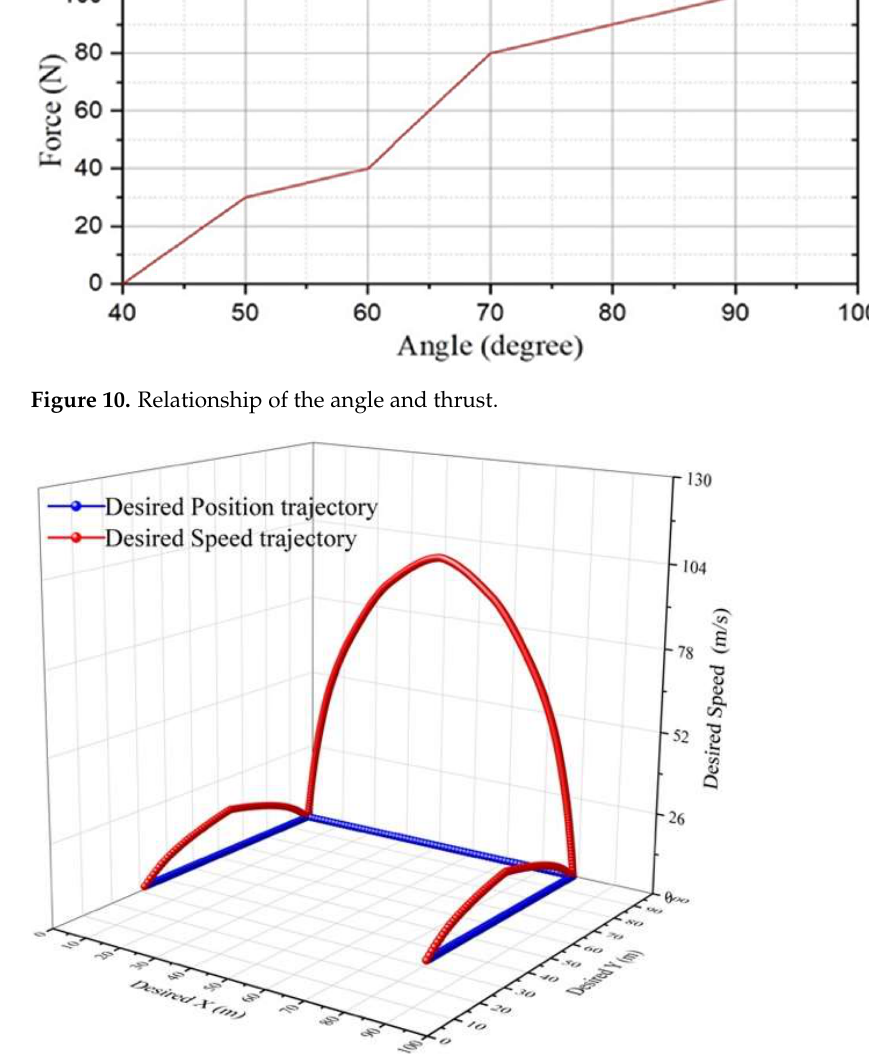
Figure 11. Speed and position trajectory.